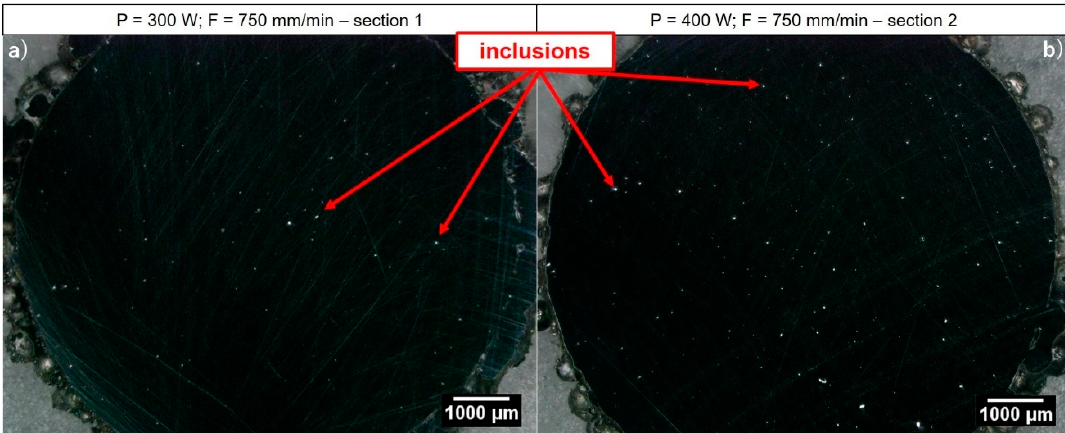
Figure 14. Segregation distribution on the cross-section of as-built Inconel 718 specimens: ( a ) cylinder built at P 300 W and F 750 mm/min; ( b ) cylinder built at P 400 W and F 750